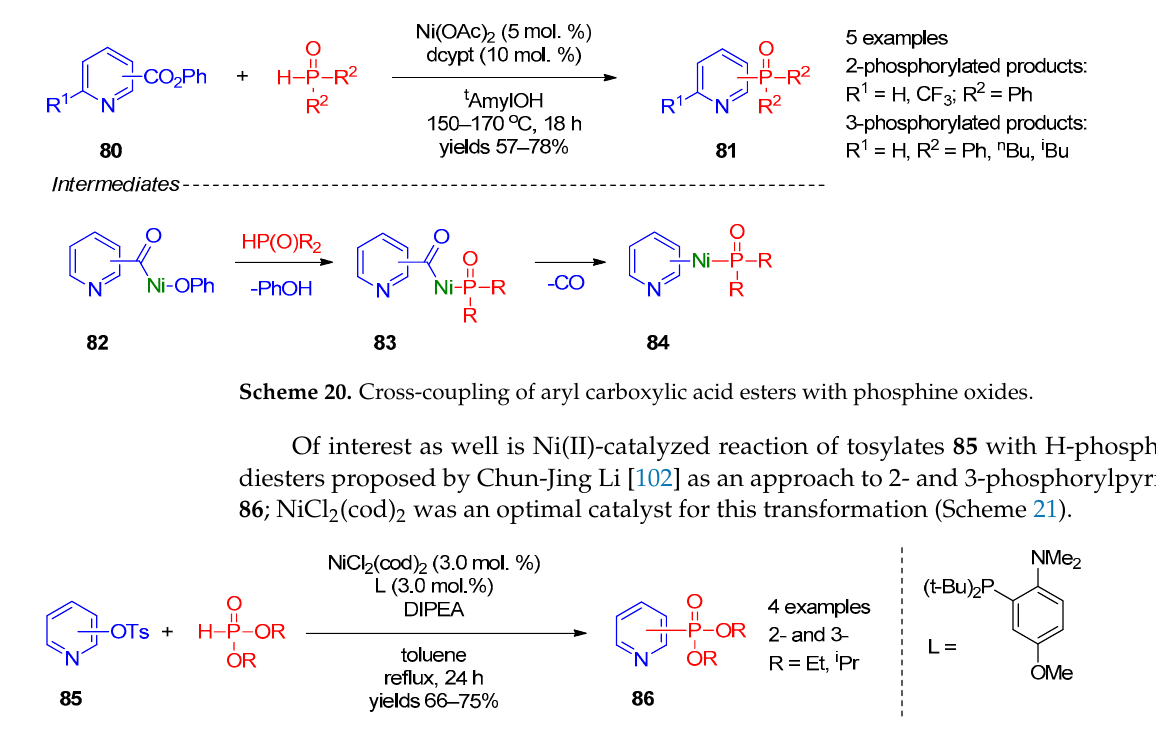
Figure 2. Approaches to synthesis of POR 2 -containing pyridazines.